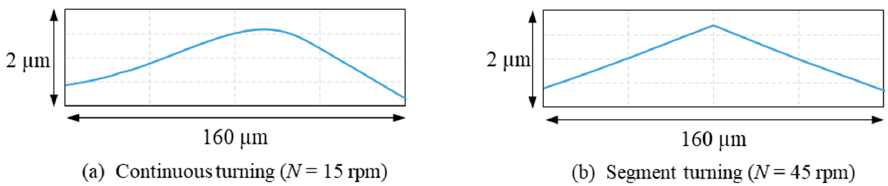
Figure 9. Effect of linear interpolation on lens edge formation for ( a ) continuous turning and ( b ) segment turning. ( a ) Continuous turning; ( b ) segment turning.